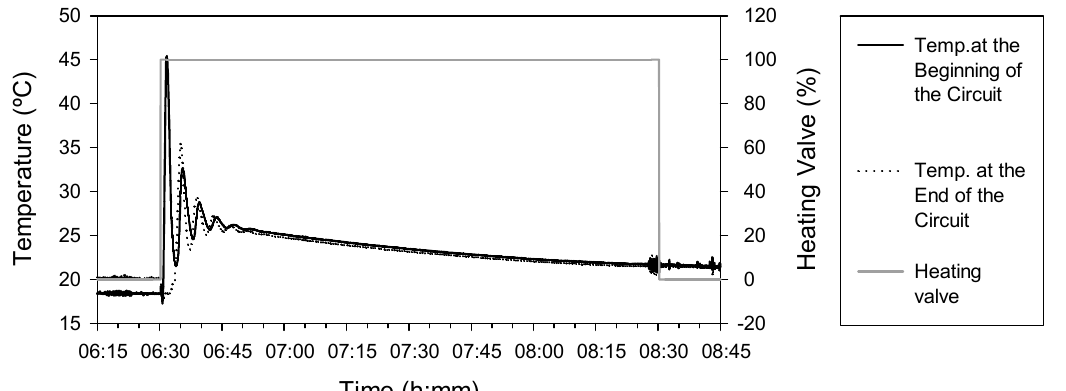
Figure A6. Experiment for estimating the energy transference from the water circuit to the greenhouse environment. The temperature change at the beginning and at the end of this circuit, and the heating valve status (100% implies that the heating is on-demand).